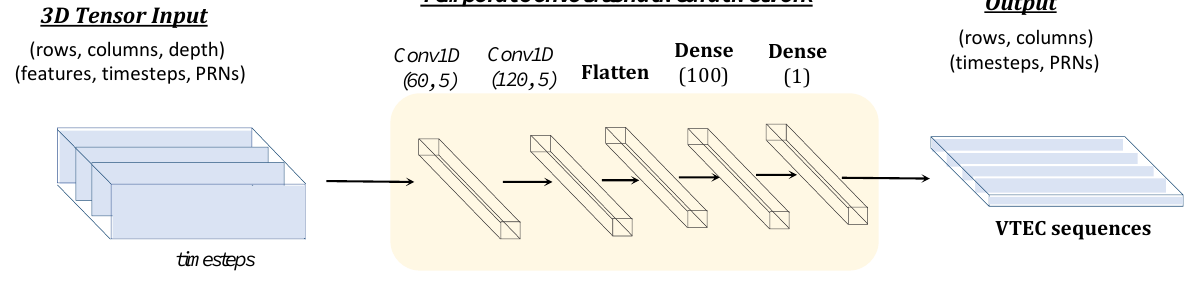
Figure 1. Temporal CNN network